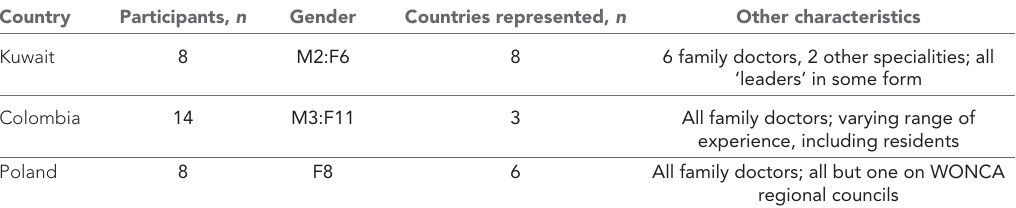
Table 2 Focus group participant